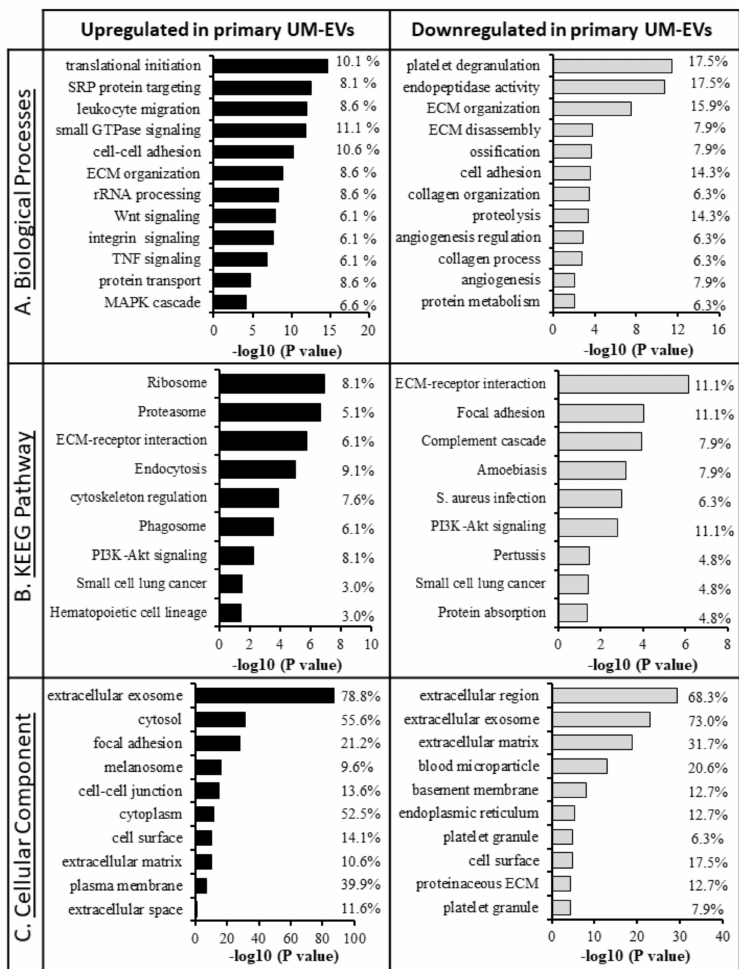
Figure 9. GO classification of proteomic data for di ff erentially expressed proteins in primary MEL270 UM-EVs and metastatic OMM2.5 UM-EVs. The most enriched categories in ( A ) biological process, ( B ) molecular function, and ( C ) cellular component. Left panel—primary UM-EVs, right panels—metastatic